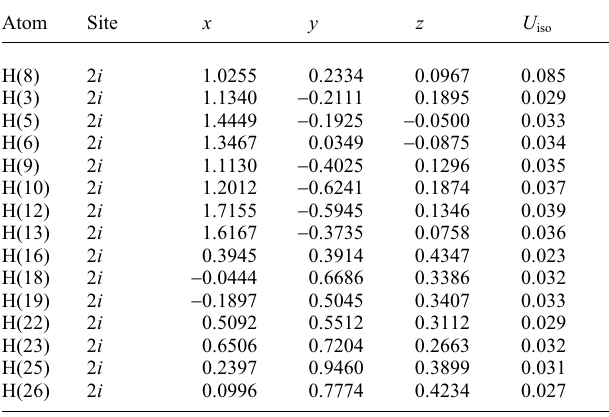
Table 2. Atomic coordinates and displacement parameters (in Å 2 ) .